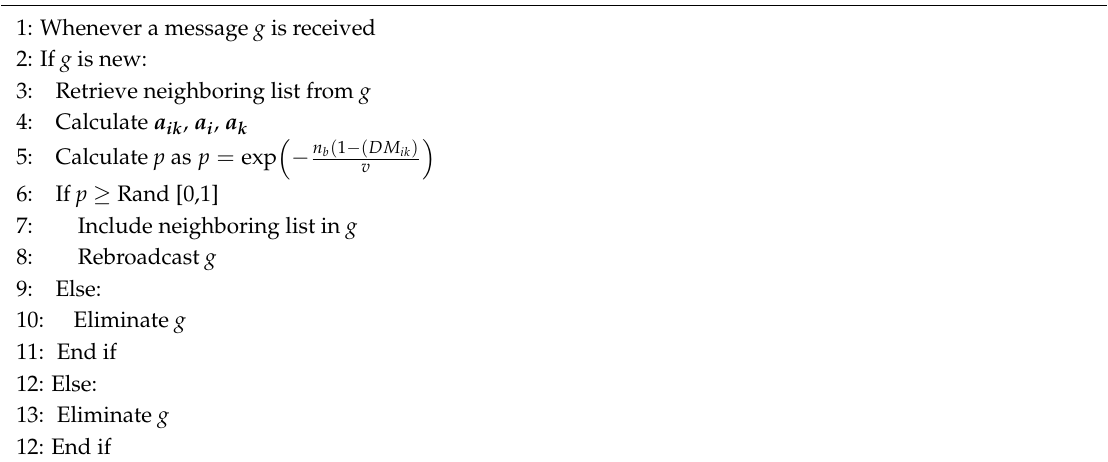
Algorithm 4. Irresponsible algorithm based on dissimilarity